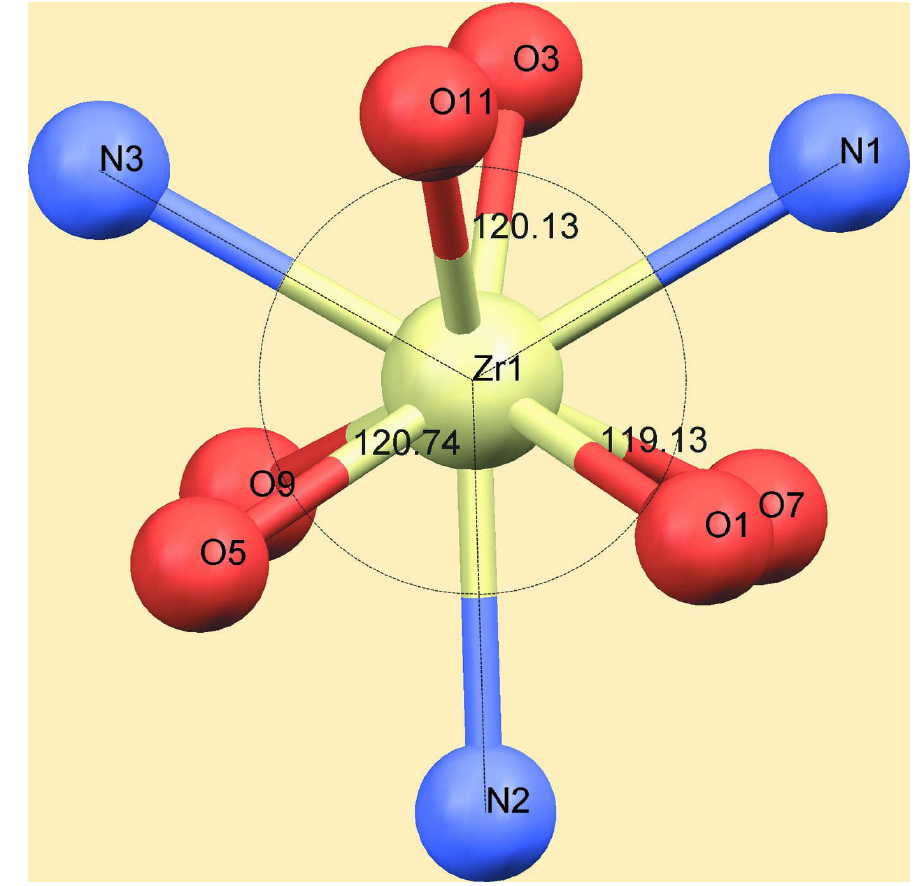
Figure 2 Coordination geometry (°) around the central